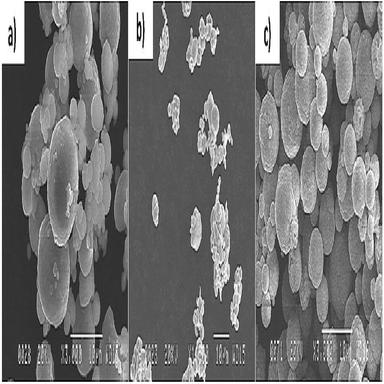
Image showing the microstructures of a) Al powder particles, b) Mo powder particles and c) Ni powder particles.